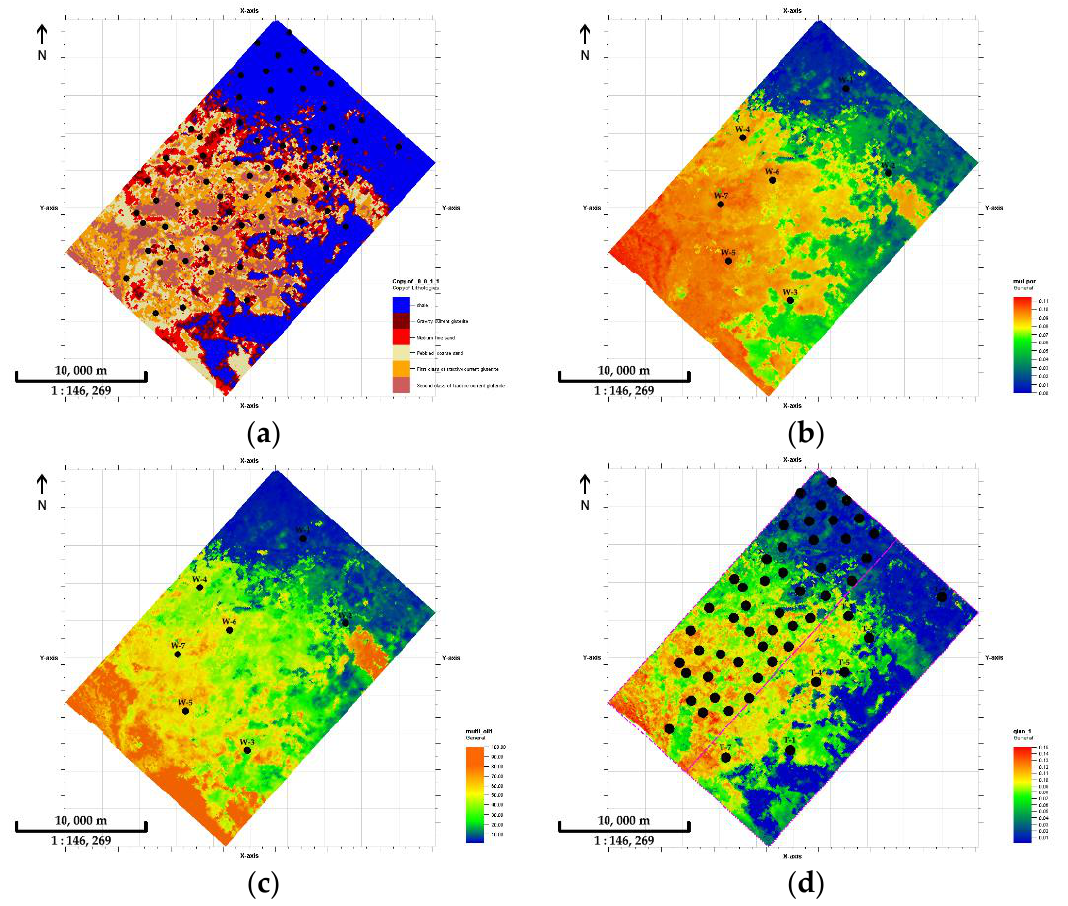
Figure 7. Reservoir physical properties model simulated by multioutput DFNN and transfer learning: ( a ) lithofacies model of the study area; ( b ) porosity model simulated by multioutput DFNN; ( c ) oil saturation model simulated by multioutput DFNN; and ( d ) porosity model simulated by transfer learning. Table 4. Test well experiment for the porosity and oil saturation modeling based on multioutput DFNN.